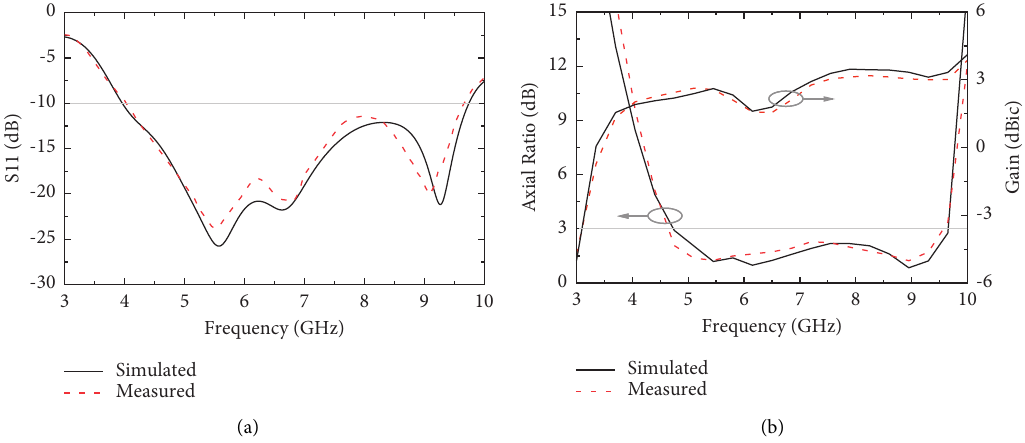
Figure 10: Simulated and measured (a) S11. (b) AR and